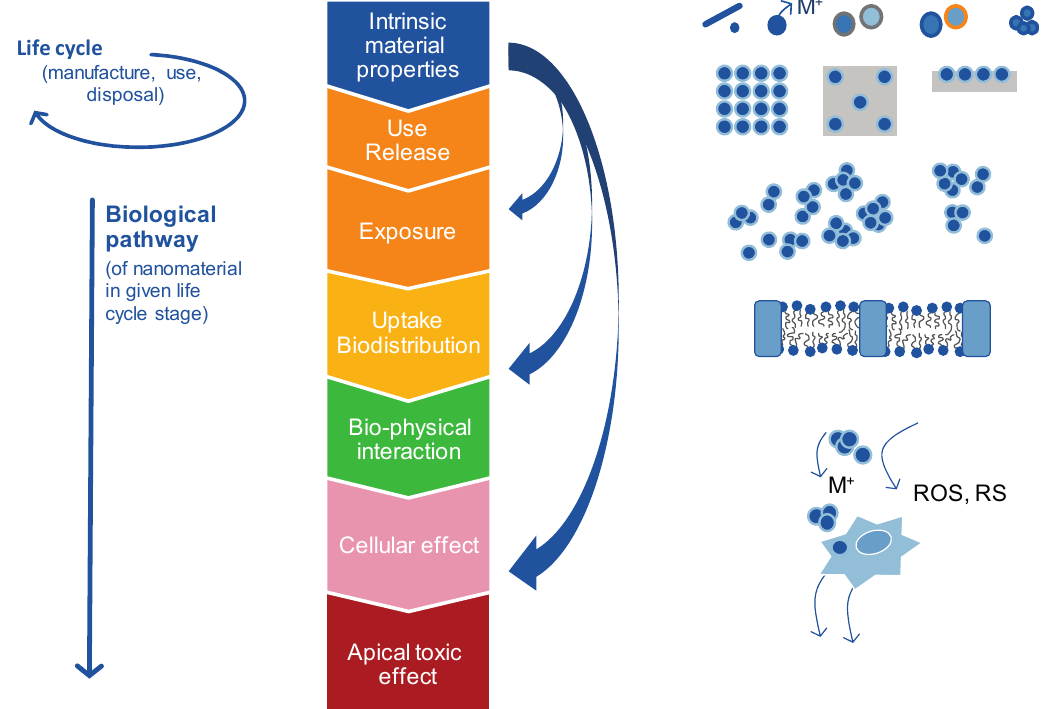
Figure 2. A sequence of events in the life cycle and the biological pathways that can influence the apical effect (adapted from Arts et al . [2], Arts et al . [3], Oomen et al . [4]). Material physicochemical properties (blue) affect exposure (orange), toxicokinetics (yellow, green) and hazards (pink, red) in potentially different ways, and thereby influence the apical effect. This should be taken into consideration in grouping and read-across